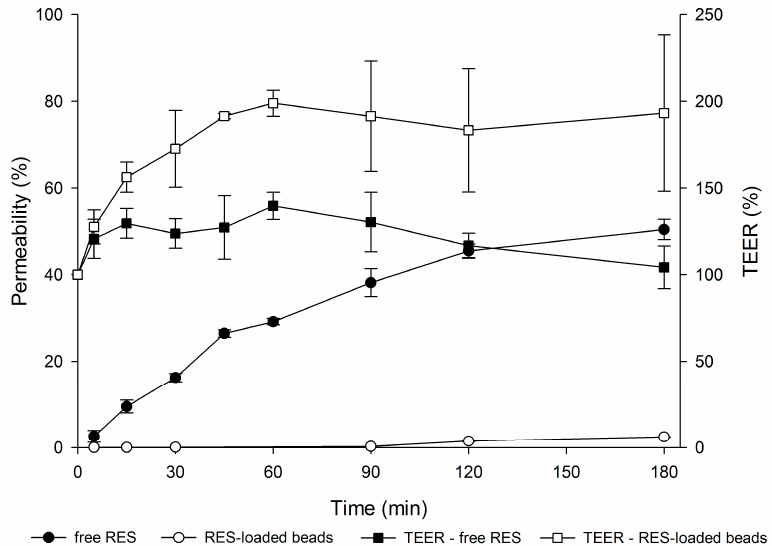
Figure 5. Permeability profile of free RES and RES-loaded beads across a triple co-culture model and TEER (%) of the cell monolayer as a function of time during the experiment ( n = 3; mean ± SD).